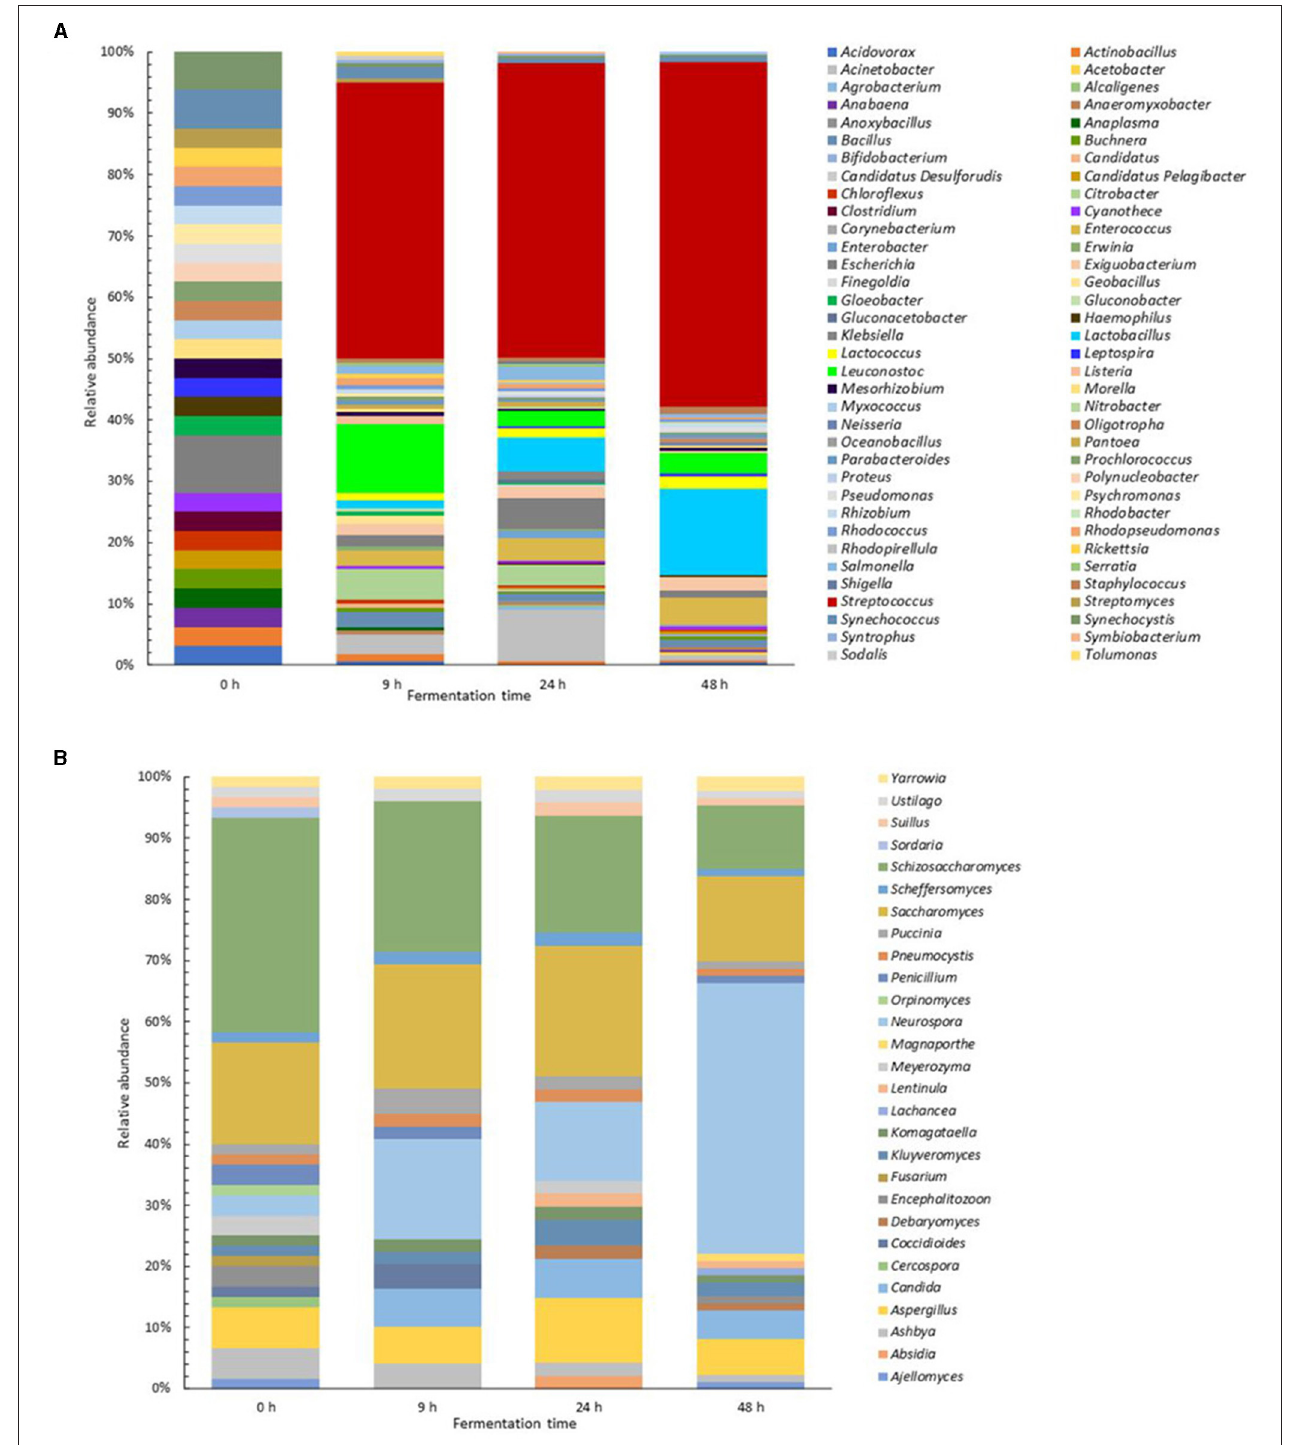
FIGURE 4 | Abundance by gender and fermentation time of the proteins identified in the pozol metaproteome. Proteins were identified from 2 unique peptides in MS/MS analysis. (A) Bacteria proteins. (B) Fungal proteins.